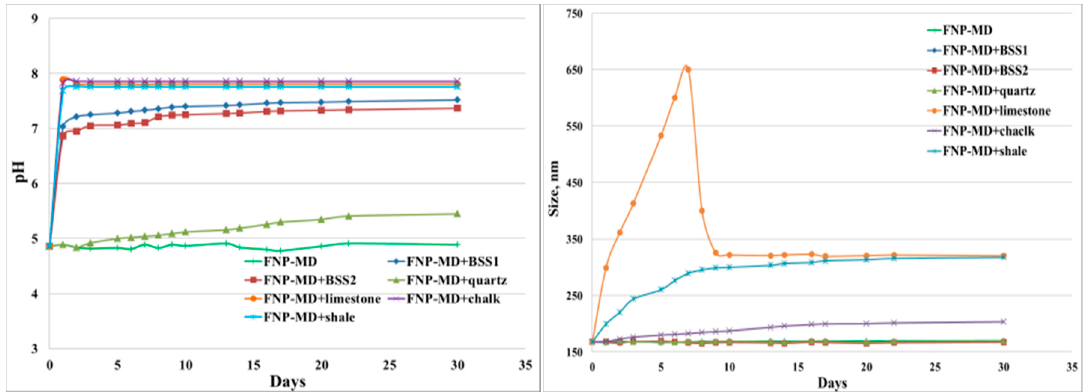
Figure. 11 pH and particle size measurements for FNP-MD suspension with different rocks.